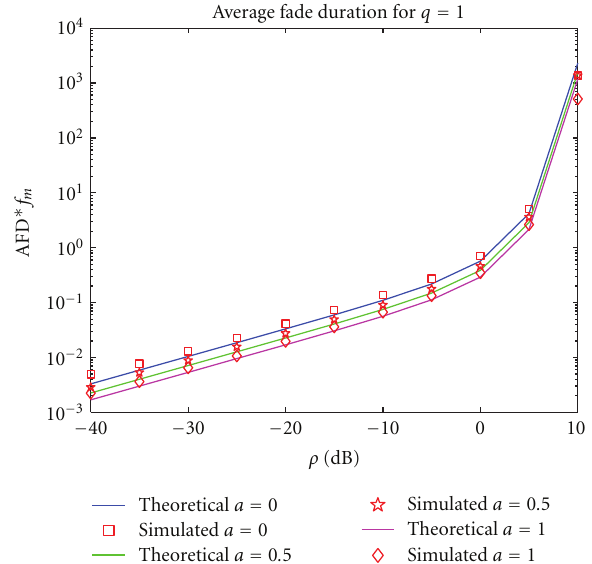
Figure 13: Average duration of fade for q = 1, k =